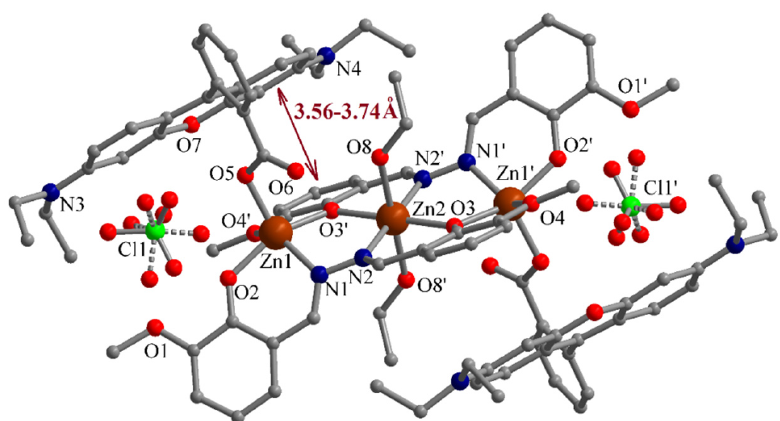
Figure 1. Perspective view of the trinuclear complex [Zn 3 (valhydr) 2 (RhB) 2 (EtOH) 2 ](ClO 4 ) 2 (sym- metry code:’ = 1–x, 2–y, –z). The hydrogen atoms were omitted for clarity. The rhodamine ligands also establish intermolecular π – π interactions through the xan- thene fragments with neighbouring complexes generating supramolecular chains running along the crystallographic c axis (Figure 2a). There is an important overlap between these fragments with a separation ranging from 3.53 to 3.72 Å. CH ··· π interactions (2.80–3.28 Å) Schiff base ligands (Figure 2b).